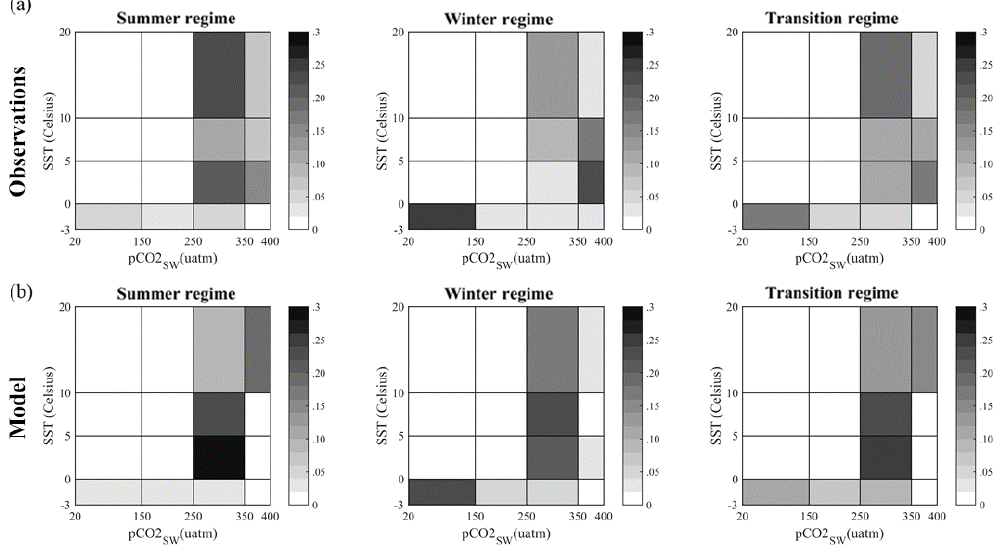
Figure 12. Comparison between the regimes in (a) the observations and (b) the model output.